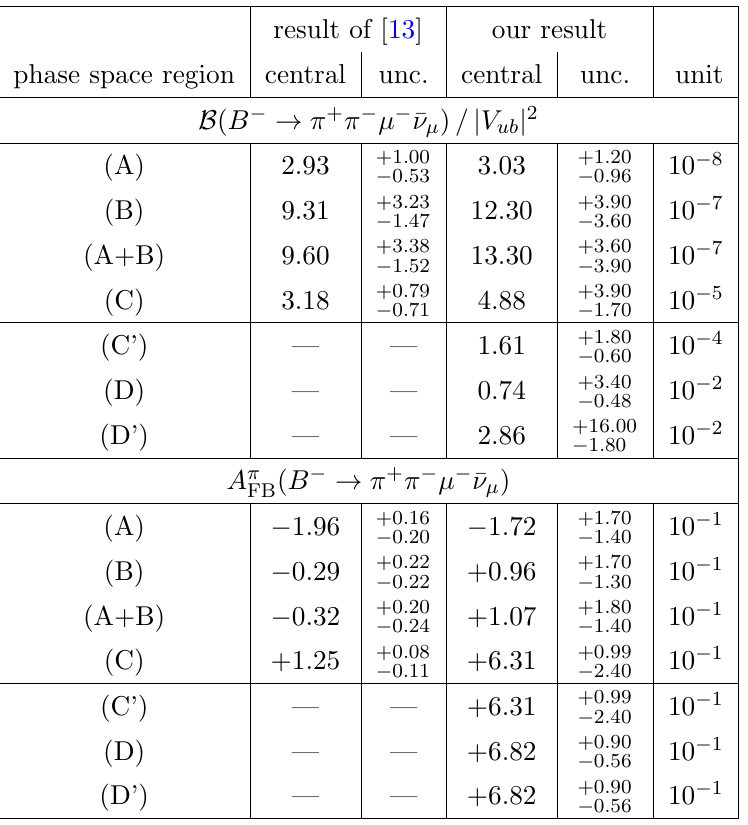
Table 2 . Results for the partially-integrated branching ratio forward-backward asymmetry A (cid:25)